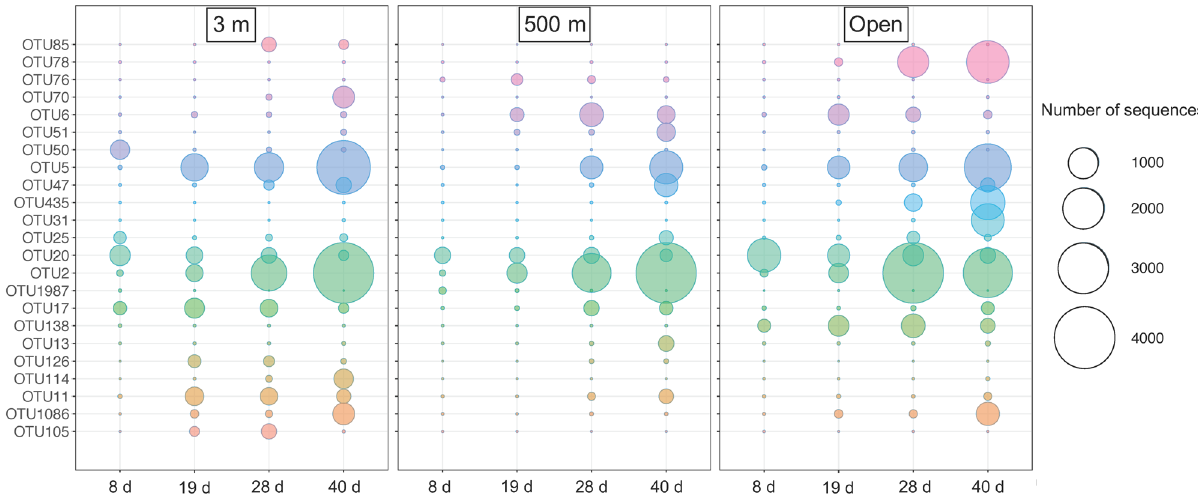
Figure 5. Relative proportion of the main bacterial OTUs in the wood at different times of incubation in aquaria inoculated with water from 3 m depth, 500 m depth or in open circulation.